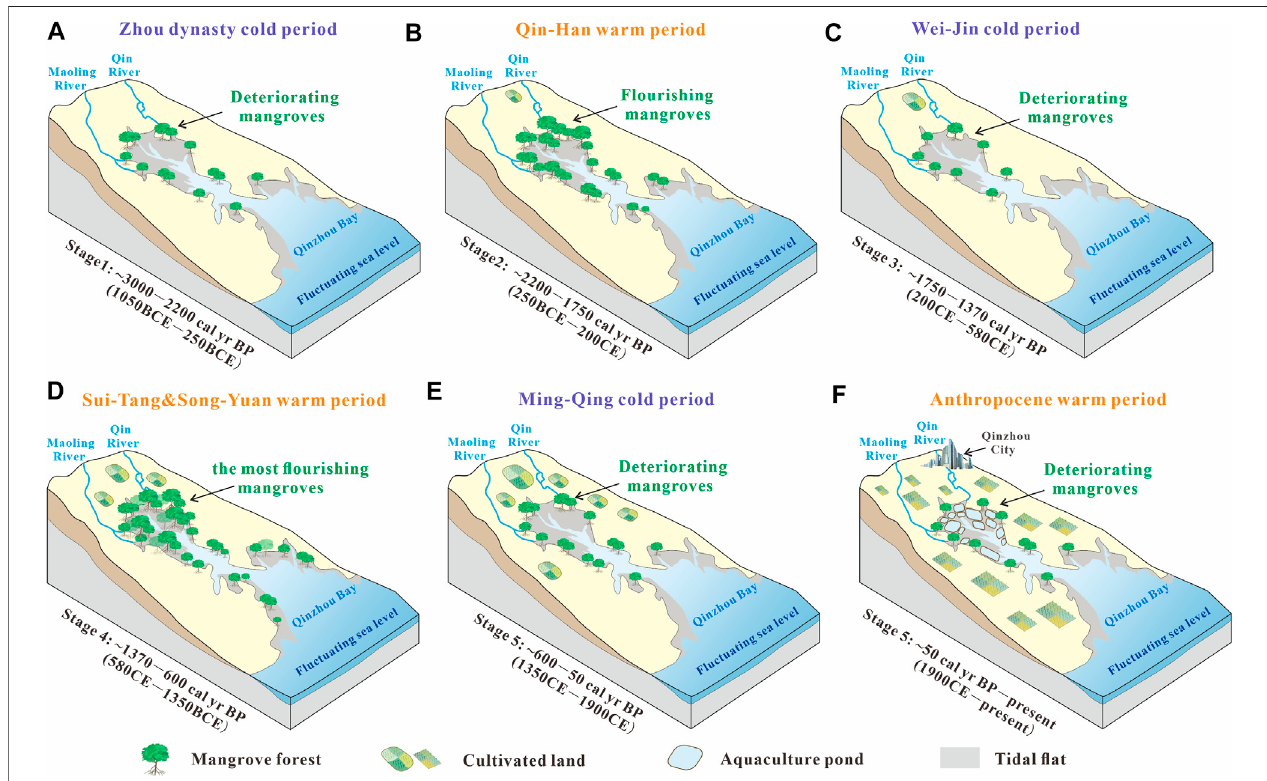
FIGURE 6 | Model of mangrove development in (A – F) different stages in Qinzhou Bay, tropical China, over the past 3000 years.